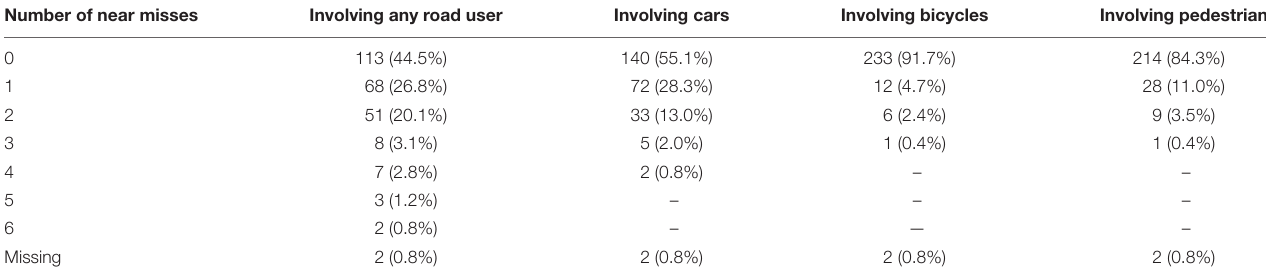
TABLE 2 | Frequency and percentages of near misses involving each type of road